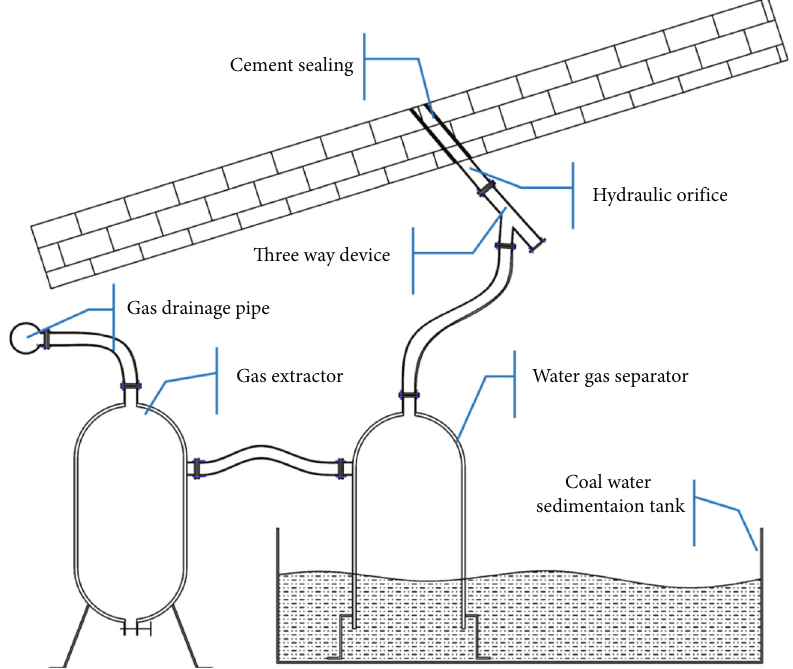
Figure 13: Water-gas separator and three-way